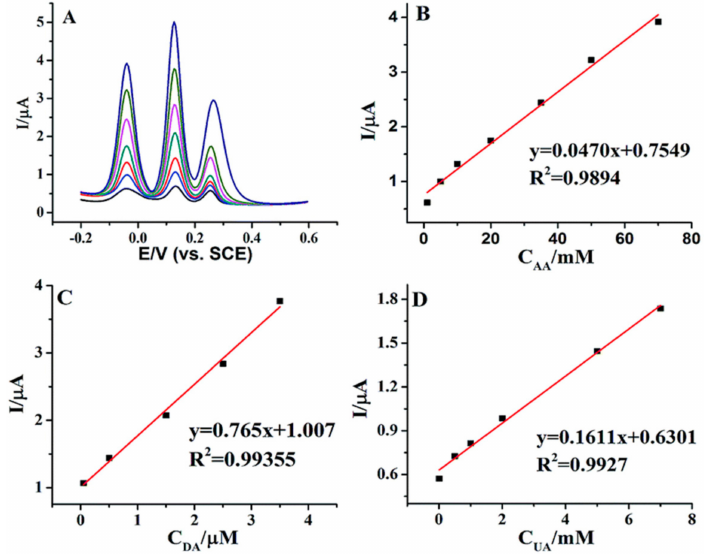
Figure 10. Simultaneous detection of DA, UA, and AA by Sun et al. ( A ) The DPV responses when exposed to AA, DA, and UA, simultaneously, and the calibration curves for ( B ) AA, ( C ) DA, and ( D ) UA. Reprinted with permission from